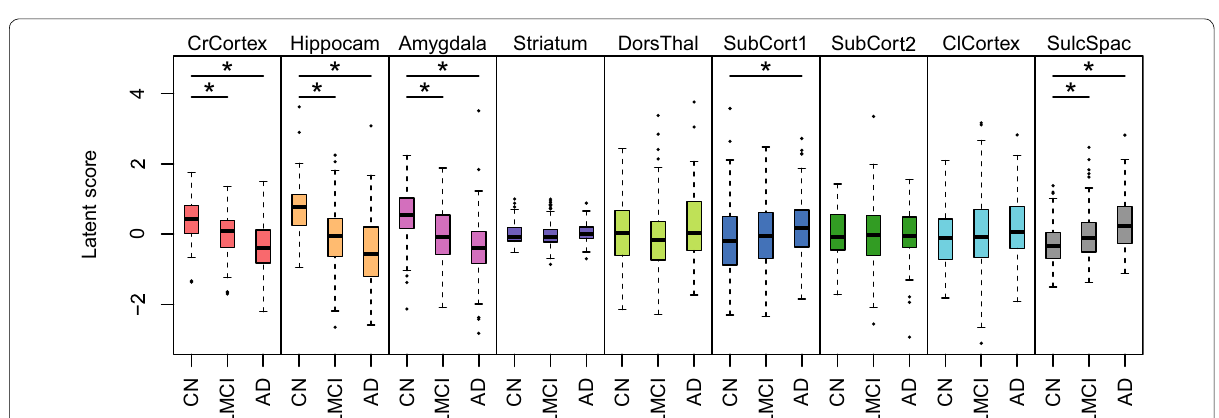
Fig. 5 Association between the validation latent variable scores and diagnosis. Diagnosis is cognitive normal (CN), late mild cognitive impairment (LMCI), or Alzheimer’s disease (AD). Nominally significant differences (ANOVA p < 0.05 ) are indicated with asterisks. The cerebral cortex (CrCortex), hippocampus (Hippocam), and amygdala (Amygdala) latent volume variables are lowered with disease progression, while the latent variable score for sulci and spaces (SulcSpac) is